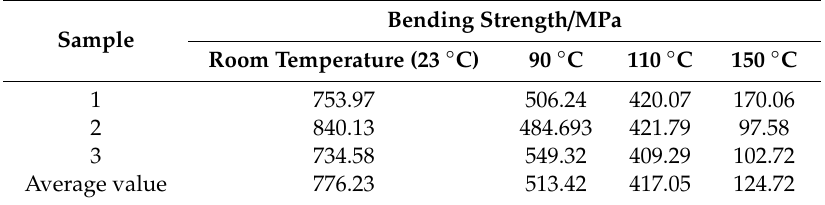
Table 5. Bending strength of 3Dim–5Dir braided composites at di ff erent